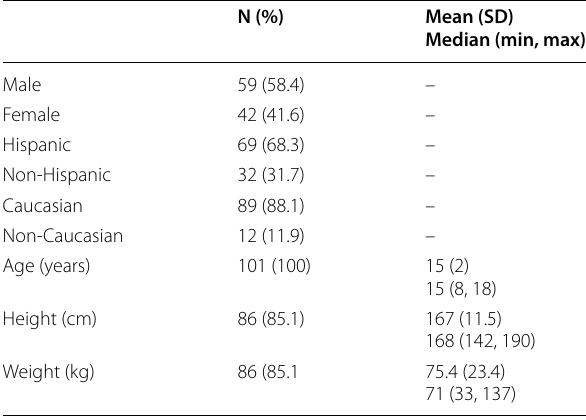
Table 2 Cruciate Ligament Comparisons Ligamentous